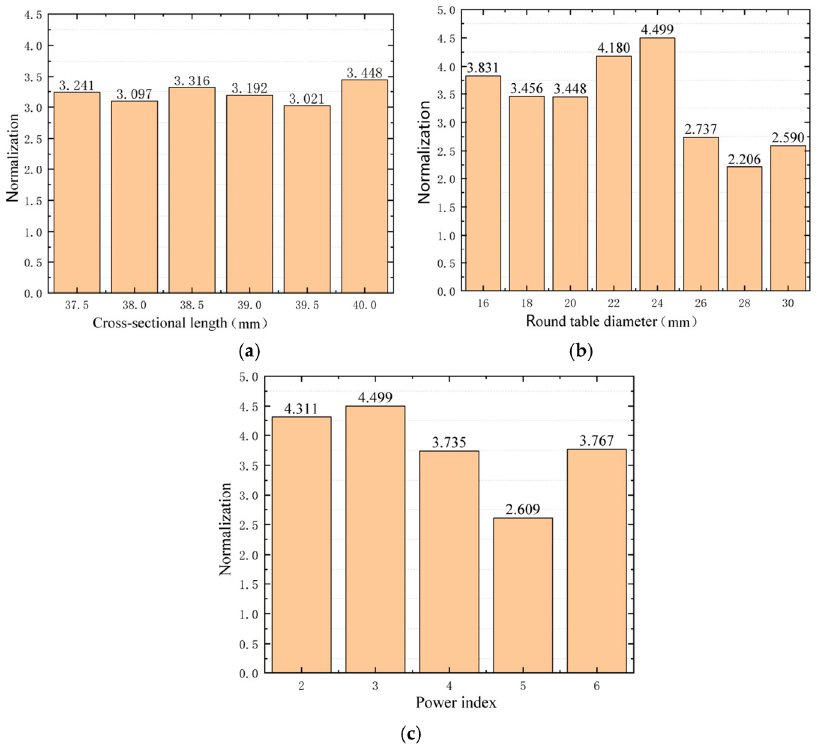
Figure 11. Parametric sweep results of ABH structural parameters. ( a ) Normalization corresponding to different cross-sectional length, ( b ) Normalization corresponding to different round table diameter, ( c ) Normalization corresponding to different power index,